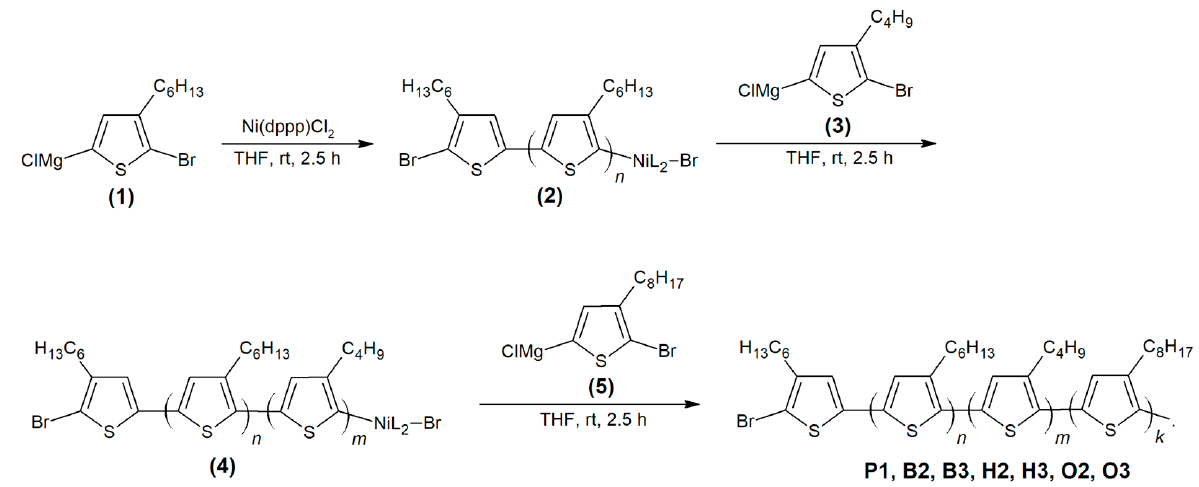
Table 1. Before the effect of the block ratios on the physical and photovoltaic properties of the tri-block copolymers can be investigated, the block ratios in the synthesized copolymers must be accurately identified.